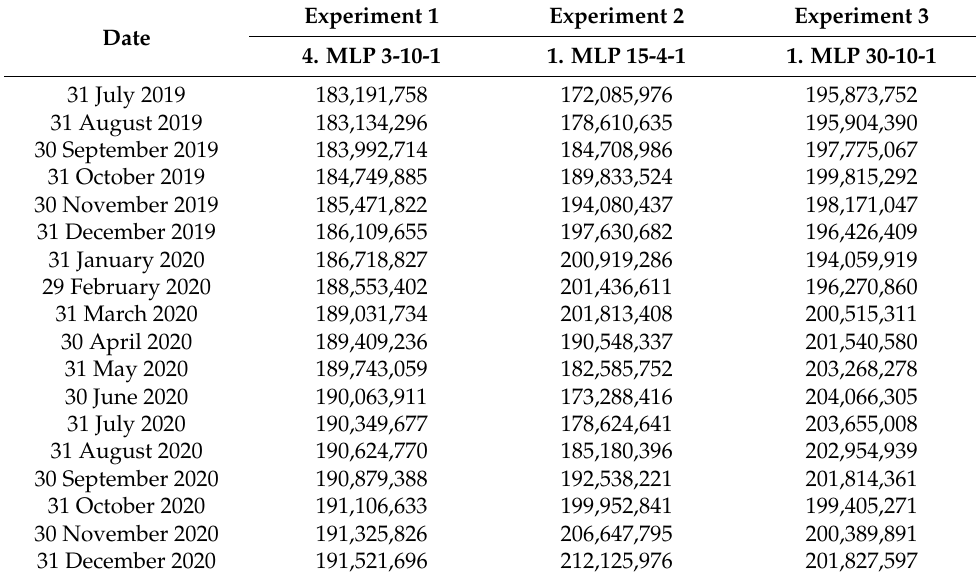
Table 8. Comparison of the most suitable neural network structures from all experiments.